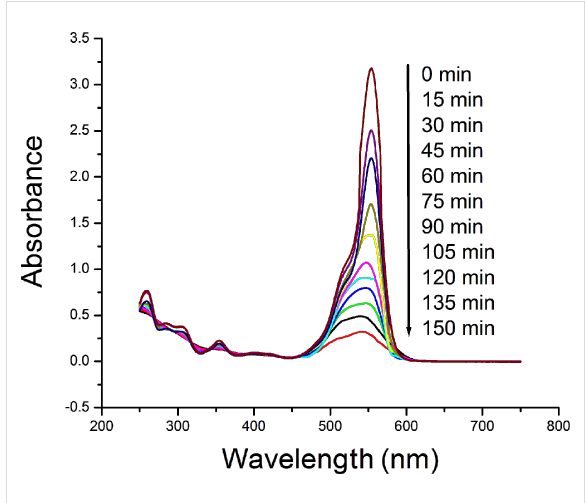
Figure 11: Effect of the concentration of Ta 2 O 5 nanoparticles on the rate of degradation of rhodamine B.